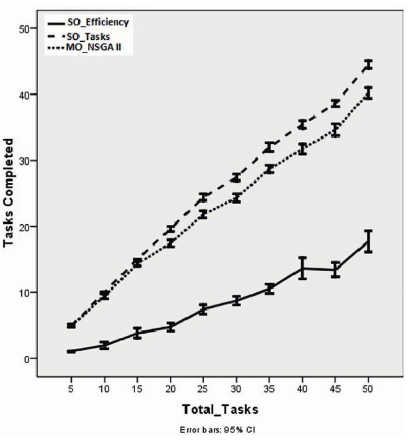
Figure 4. Simulations to contrast the solutions obtained with both single-objective (SO) and multi-objective (MO)